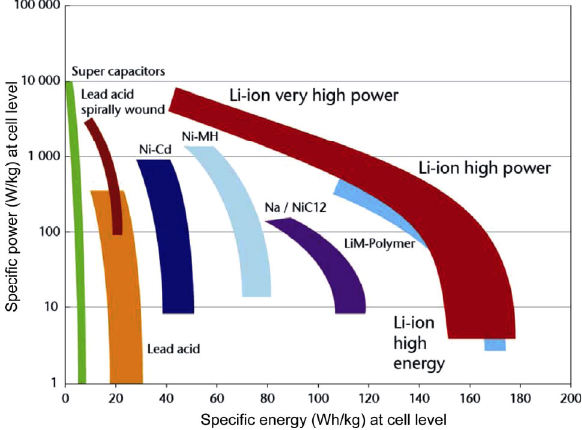
Fig. 17 Specific power versus specific energy of different electrochemical energy storage systems (note: Ni–Cd = nickel–cadmium; Ni–MH = nickel–metal-hydride; Na/NiCl2 = sodium/nickel chloride; LiM–polymer = lithium-metal–polymer; Li-ion = lithium ion; W/kg = watt per kilogram; Wh/kg = watt–hour per kilogram) (source: International Energy Agency, Technology Roadmaps: Electric and Plug-in Hybrid Electric Vehicles, 2009, p. 12. (original source: Johnson Control – SAFT 2005